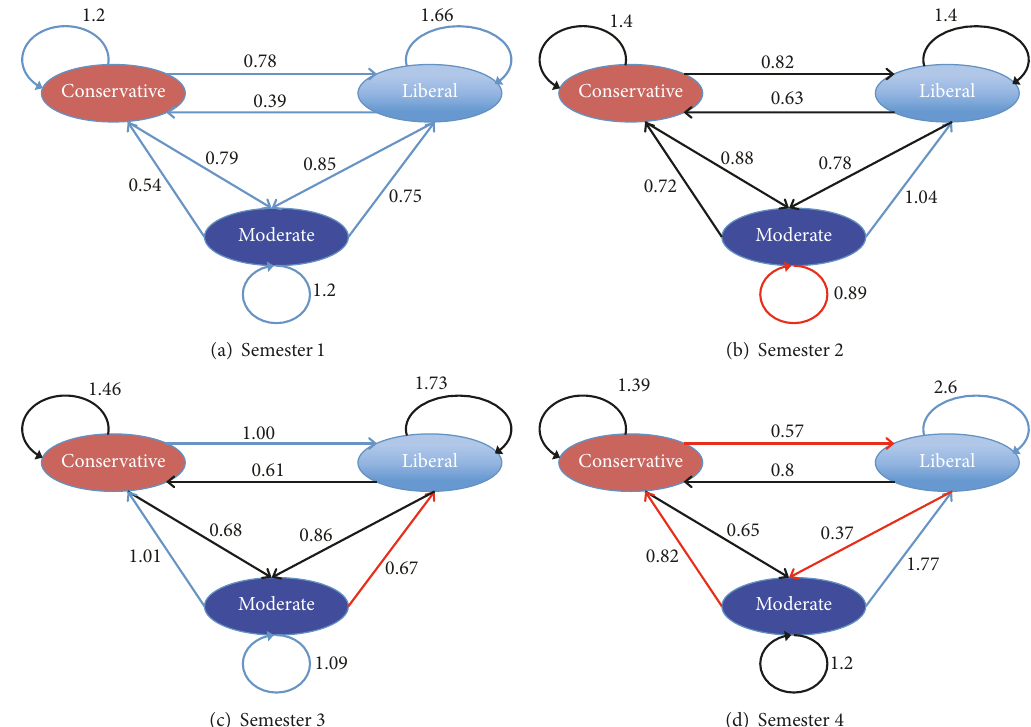
Figure 1: Views on politics, the average preference of nodes with a particular attribute value for all values of the